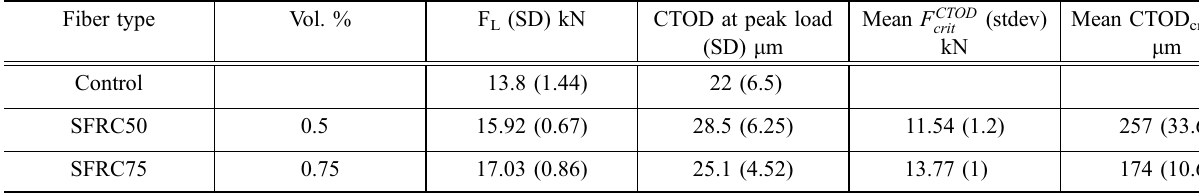
Fig. 2 Load-CMOD response from flexure tests a up to a CMOD = 3 mm; and b early response up to CMOD = 0.1 mm. The average response of five beams is plotted with scatter bars indicating the range of variation at discrete values of CMOD. Table 2 Load and CTOD measures from tests on notched beam.